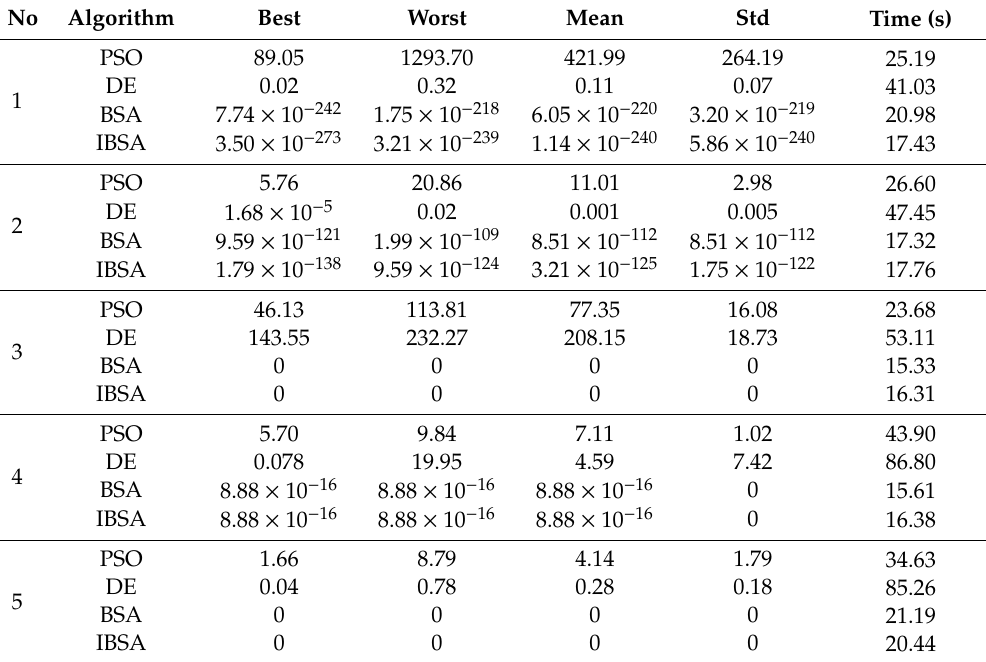
Table 3. The statistical results of di ff erent